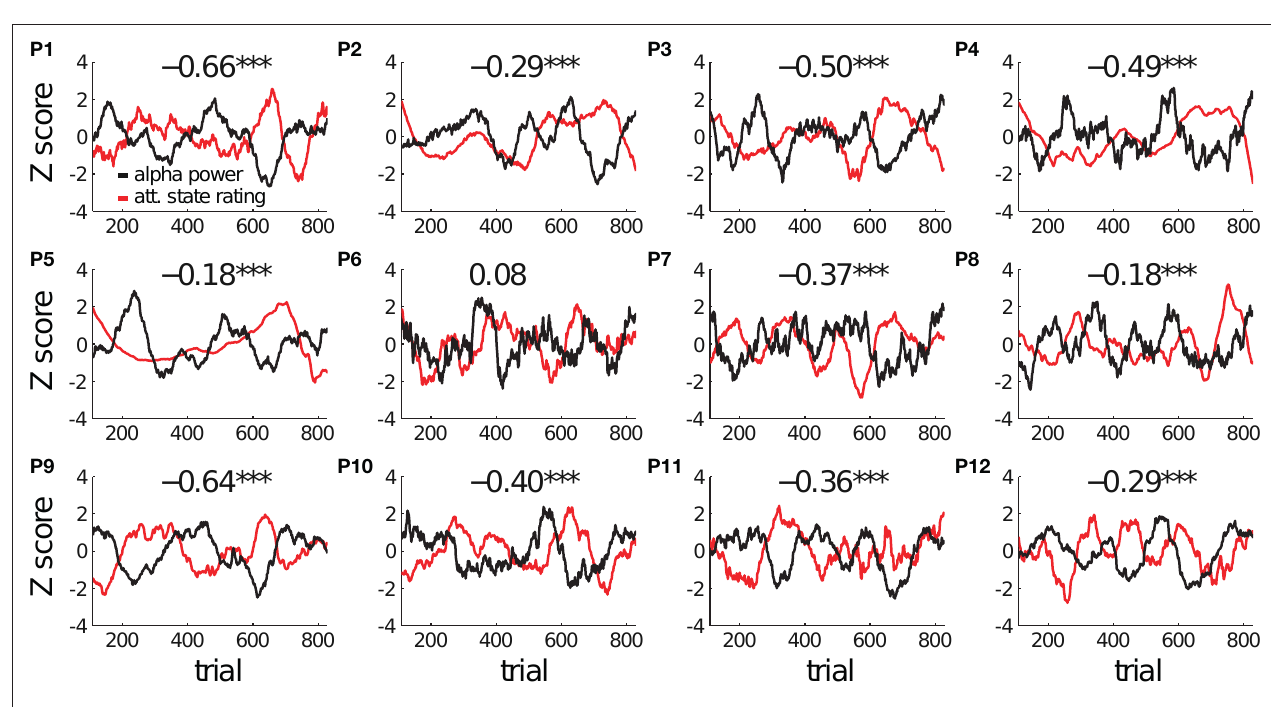
Figure 7 | individual participants’ smoothed time series of attentional state ratings and prestimulus eeg alpha power. Normalized time series smoothed with a sliding window size of 75 trials are shown for each participant